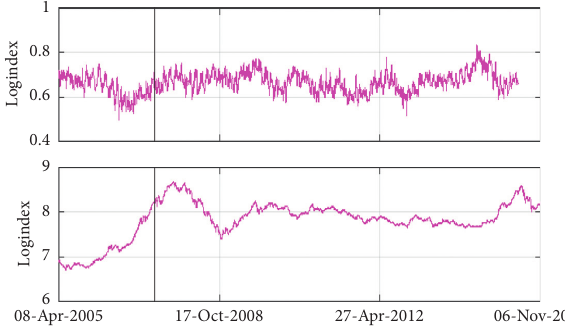
Figure 8: The results of the Hurst exponent when N � 120.